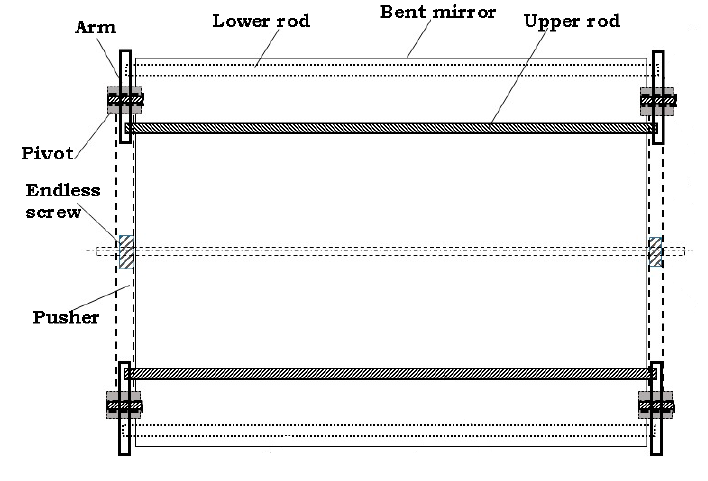
Figure 6. Upper view of the bent mirror.